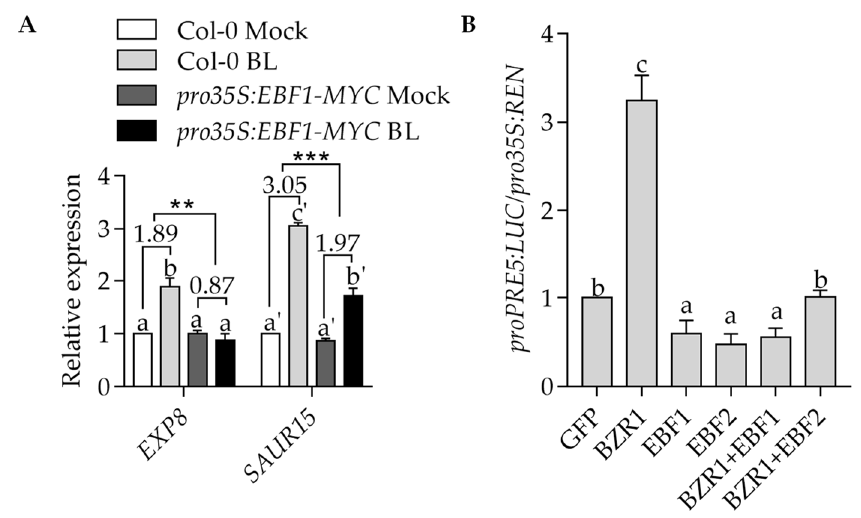
Figure 3. EBF1 inhibited the expression of BZR1 target genes. ( A ) Quantitative RT-PCR showed that EBF1 reduced the BL-promoted gene expression. Total RNAs were extracted from 7-day-old seedlings grown on 1 / 2 MS medium with or without 100 nM BL for 3 h. PP2A gene was analyzed as an internal control. Error bars are SD of three biologic replicates. Different letters above bars, such as a, b, a’, b’ and c’, indicate statistically significant differences between samples (two-way ANOVA followed by post hoc Tukey test, ** p < 0.01, *** p < 0.005). ( B ) Transient reporter gene assays showed that EBF1 and EBF2 inhibited the BZR1-promoted expression of pPRE5:LUC reporter gene. The dual luciferase reporter construct containing proPRE5:LUC (luciferase) and 35S:REN (Renilla luciferase) was co-transfected with pro35S:GFP , pro35S:BZR1-GFP and/or pro35S:EBF1-GFP and pro35S:EBF2-GFP into mesophyll protoplast of wild-type plants. The LUC activity was normalized to REN. Error bars represent standard errors of three biological repeats. Different letters above bars, such as a, b and c, indicate statistically significant differences between samples (one-way ANOVA followed by post hoc Tukey test, p < 0.05).